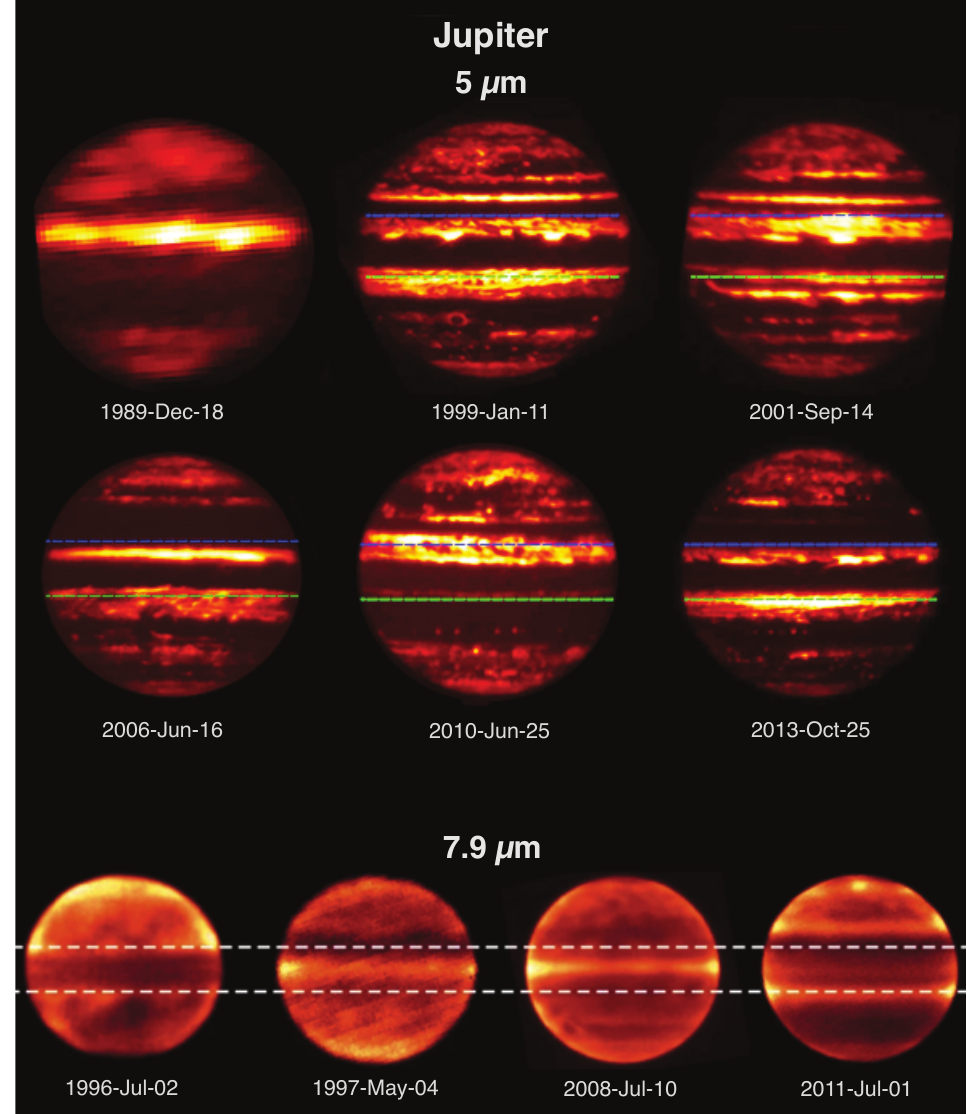
Figure 16. Sequences of mid-infrared images of Jupiter at 5 µ m (top) and 7.9 µ m (bottom) showing changes over time, adapted from Antuñano et al. [385] and Antuñano et al. [387]. Variation at 5 µ m suggests changes in tropospheric temperature and cloud opacity, with large temporal variability mainly at the equatorial and tropical latitudes and less temporal variability at mid-latitudes [385]. Dashed blue and green lines mark 16 ◦ N and 10 ◦ S planetocentric latitudes, respectively. Emission at 7.9 µ m sense stratospheric temperatures (via methane emission), revealing roughly periodic variation associated with the quasi-quadrennial oscillation [387]. 5- µ m images are from various instruments on the IRTF, including BOLO-1 (1984) [384], NSFCam (1999, 2001) [388], NSFCam2 (2006) [51], and SpeX (2010, 2013). 7.9- µ m images are from IRTF-MIRLIN (1996, 1997) and IRTF-MIRSI (2008,